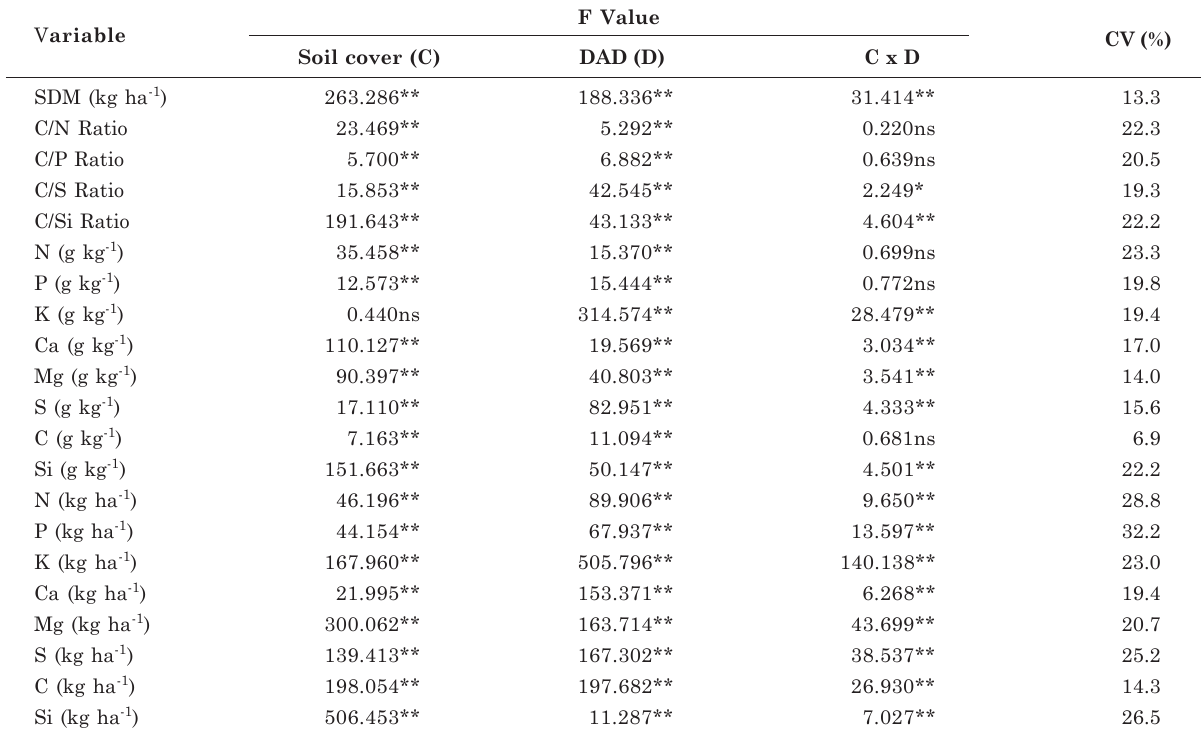
Table 1. Analysis of variance for variables related to shoot dry matter (SDM), ratios between carbon, nutrients and Si, nutrient and Si concentration and content of nutrients and Si remaining in the monoculture